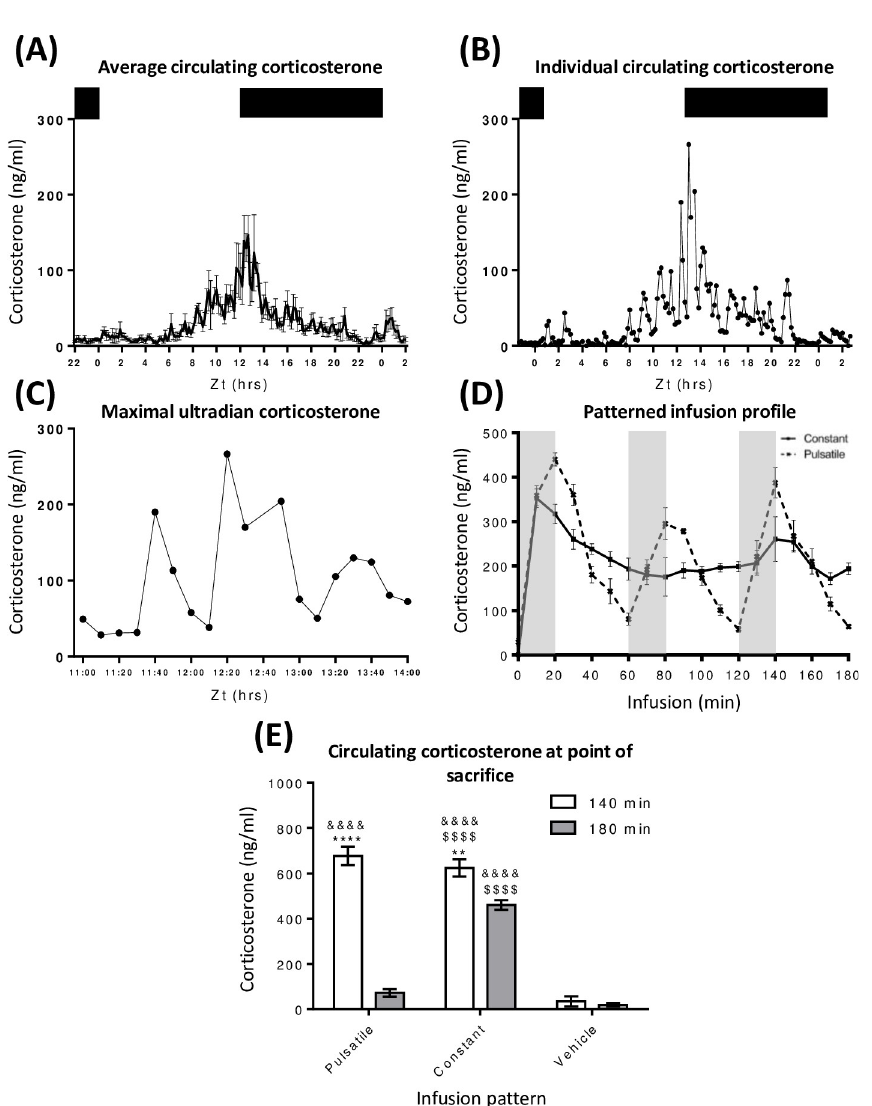
Fig 1. Validation of both the dose and infused patterns of CORT within the circulation of the rat. (A) Blood samples were taken every 10 min over a 28 hr period. CORT levels gradually increased from basal (Zt 0–6) to maximal levels at Zt 12:40. Levels decreased from this point returning to baseline by Zt 22. Lights were 12:12 (lights off at Zt 12), N = 6 and data is expressed as mean ± s.e.m.. (B) Circulating CORT levels from a single rat indicate approx. hourly oscillations in CORT in a classical ultradian profile which are (C) most discernible during maximal circadian secretions, as indicated between Zt 11–14. N = 1. (D) 1 ml of CORT (3.84 μ M) was delivered intravenously over 3 hrs in a PULS manner (dashed line) via 20 min (grey bar), hourly CORT infusions at a rate of 1 ml/ hr, whilst the CONS (solid line) rate of 0.33 ml was maintained throughout the experimental period. Peaks in circulating CORT were observed at 20 min, 80 min and 120 min (353 ng/ ml ± 42) post each 20 min infusion and was cleared from the circulation within each 40 min pump cessation at 60 min, 120 min and 180 min (68 ng/ ml ± 20). CONS-induced sustained circulating levels (222 ng/ ml ± 12) between 10–180 min of infusion. Area under the curve analysis confirmed no difference in dose delivered per hr. N = 4 and mean ± s.e.m.. (E) Total circulating CORT was measured from trunk blood samples taken at the point of euthanasia (140 min and 180 min) after either PULS, CONS or VEH. Two-way ANOVA indicated a significant effect of time, infusion pattern and interaction (p < 0.0001) in response to infusions. Post-hoc tests indicated significantly raised CORT at PEAK_140 min compared to both NADIR_180 and VEH (p < 0.0001) time points. In response to CONS, CORT was raised at both 140 min and 180 min compared to NADIR_180 and VEH (p < 0.0001), but there was a significant reduction in CORT from 140 min at 180 min (p < 0.01). Lights were 12:12 (Zt 12 lights off as indicated by the top black bar) and represents total blood serum CORT levels. N = 7 and mean ± s.e.m. and significant comparisons between CORT infused and VEH infused matched time points indicated by &&&& p < 0.0001, between CORT infused time points by �� p < 0.01 and ���� p < 0.0001 and between infusion patterns by $ $$ $ p <